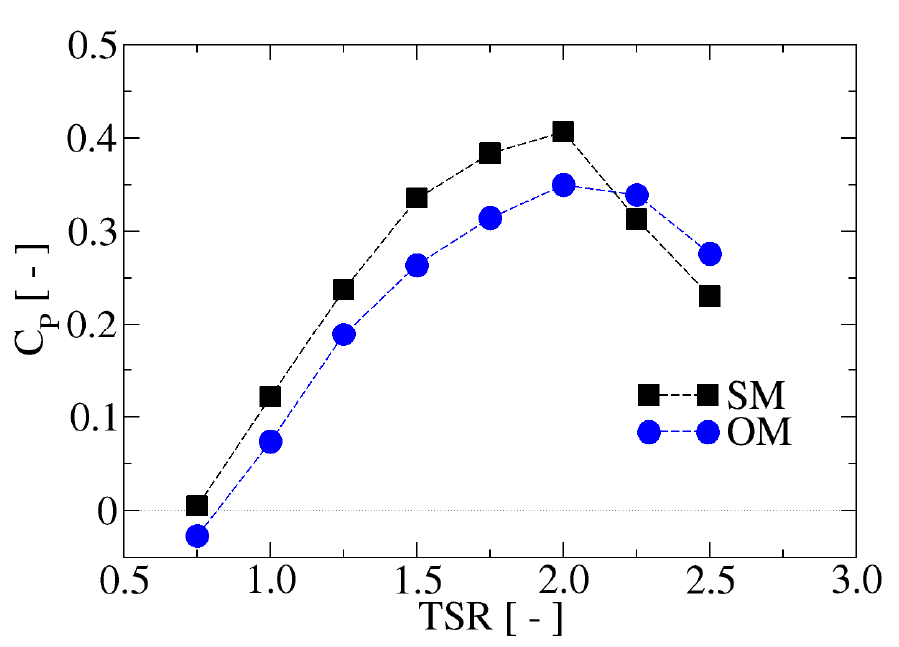
Figure 8. Power coefficient as a function of TSR.